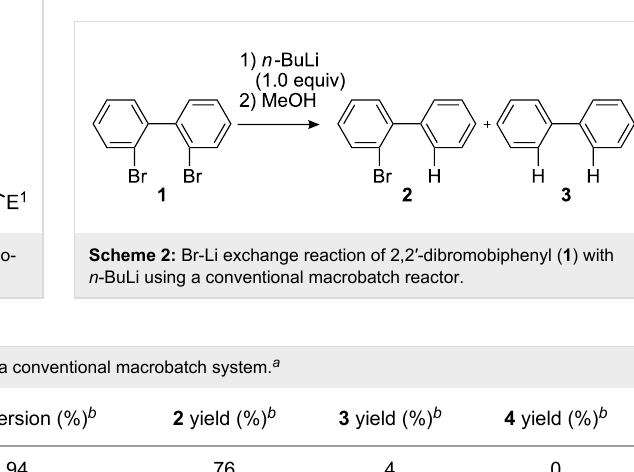
temperature (°C) reaction time